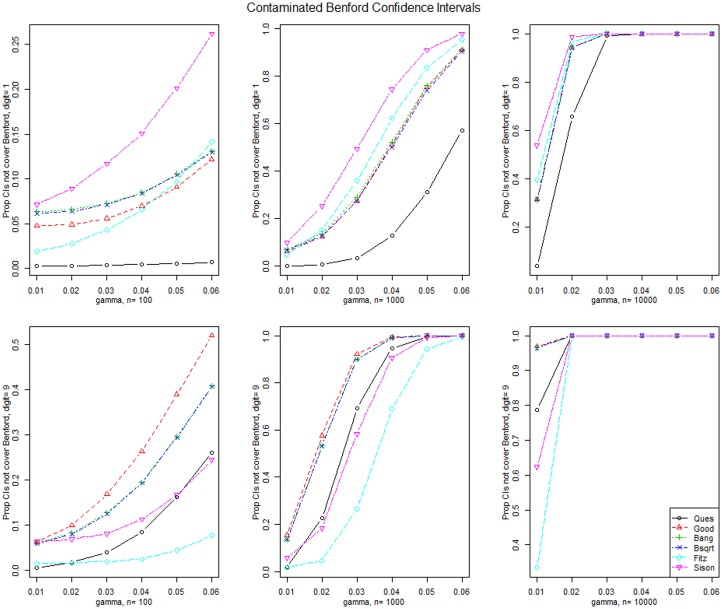
Contaminated Benford distribution CI results.Simulated power for the simultaneous confidence intervals when data are generated from the Contaminated Benford distribution where digits 1 and 9 are contaminated by an additive amount γ and for three sample sizes.